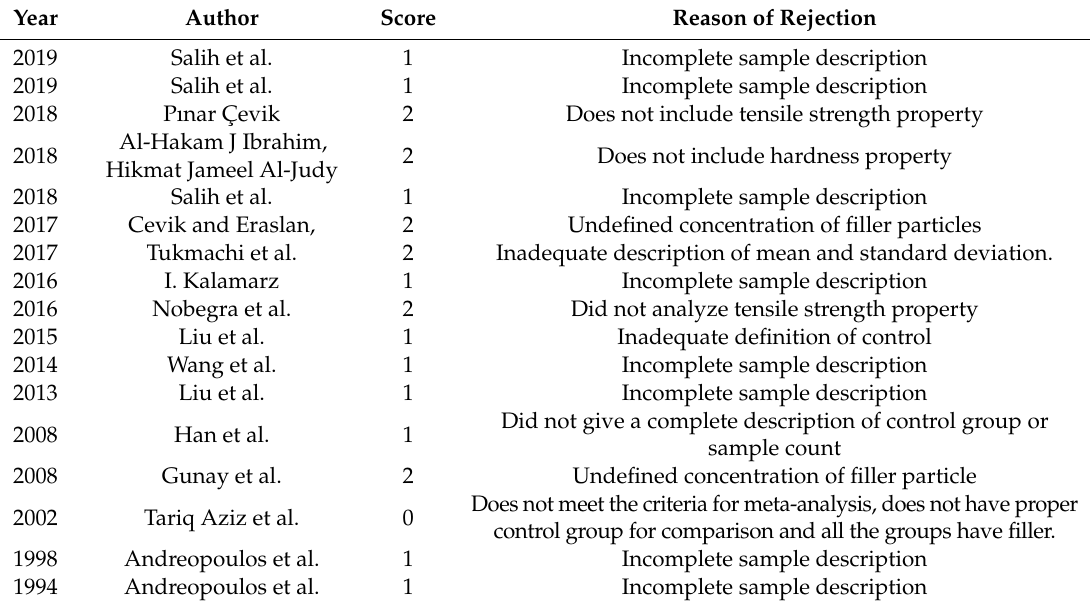
Table 2. Papers excluded from meta-analysis according to scoring criteria, with